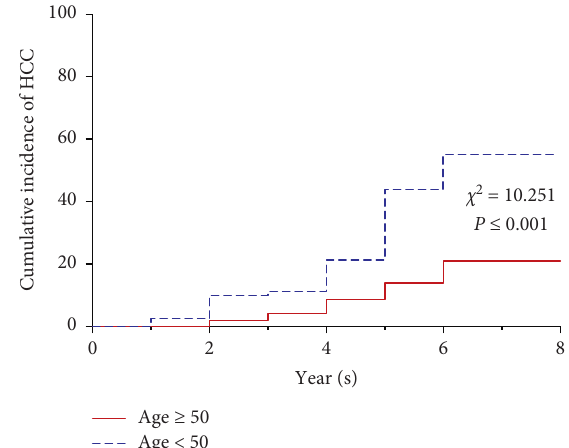
Figure 2: The incidence of HCC development between age < 50- and ≥ 50-year-old